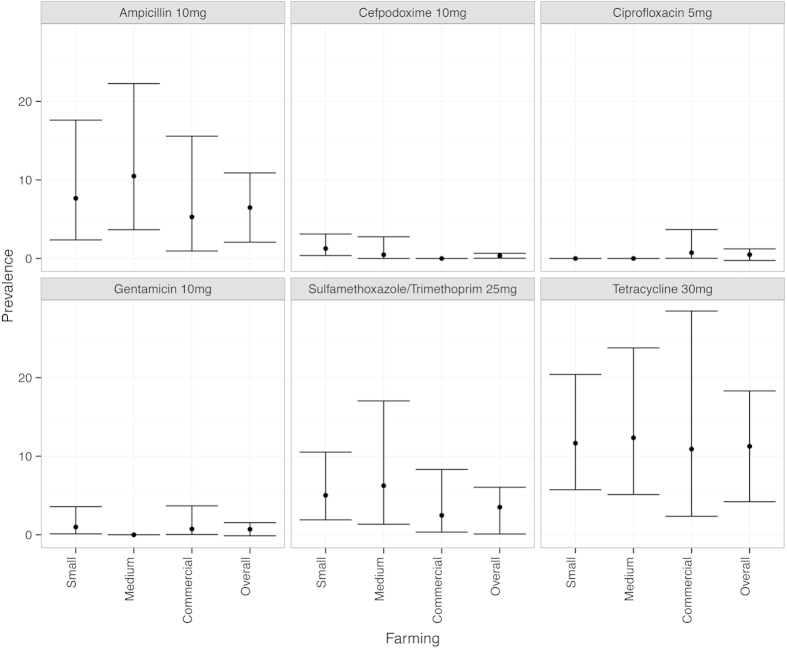
Prevalence of antimicrobial resistant E. coli to each antibiotic tested in relation to farming scale.Confidence intervals (95%) are depicted by the whiskers.